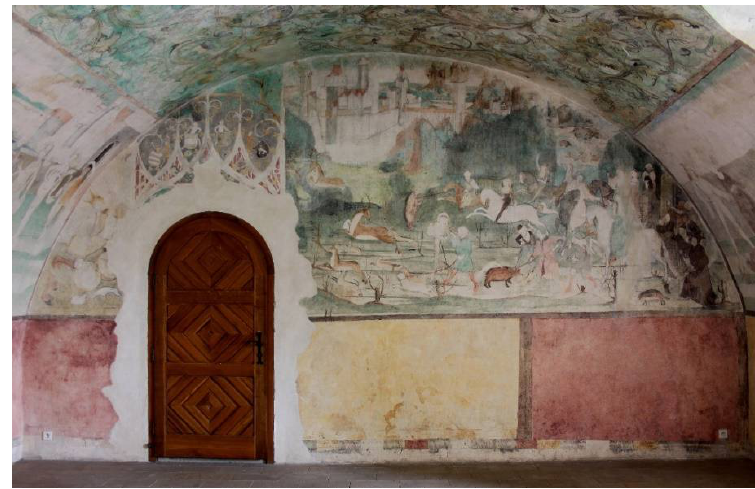
Figure 28. Žirovnice, castle. Hunting scene from a “green chamber“. Around 1490. Photo by František Záruba, the author’s own work.